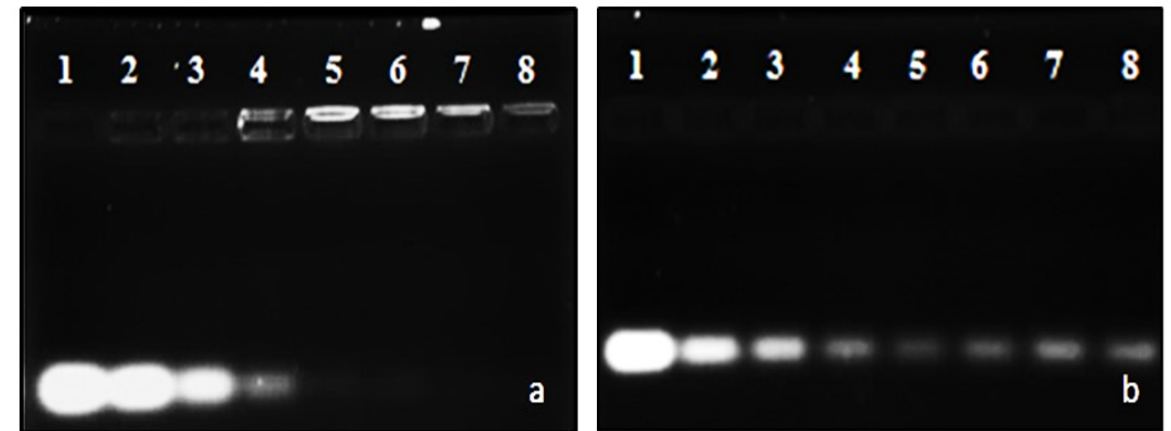
Figure 2. Gel retardation assay of the binding interactions between siRNA and cationic liposomes. Incubation mixtures (10 μl) contained siRNA (0.3 μg) and varying amounts of liposome corresponding with increasing amounts of cytofectin. Gels were viewed with ethidium bromide post-staining and UV300 transillumination. a ) MS09:DOPE and b ) MS09:Chol. In a ) lane 1 contained naked siRNA and lanes 2-8, liposome-associated siRNA (4:1 – 28:1 w / ratios); and b ) lane 1 contained naked siRNA and lanes 2-8, liposome-associated siRNA w (8:1 – 32:1 w / w